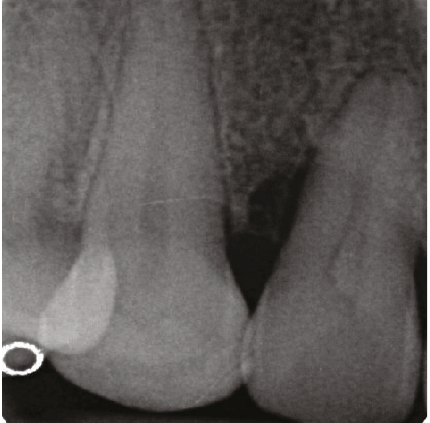
Figure 2: An angular bone defect was also visible through intraoral radiographic examination.